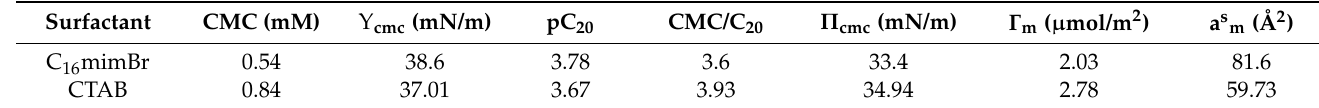
Table 4. Parameters obtained from the surface tension data at 25 °C.